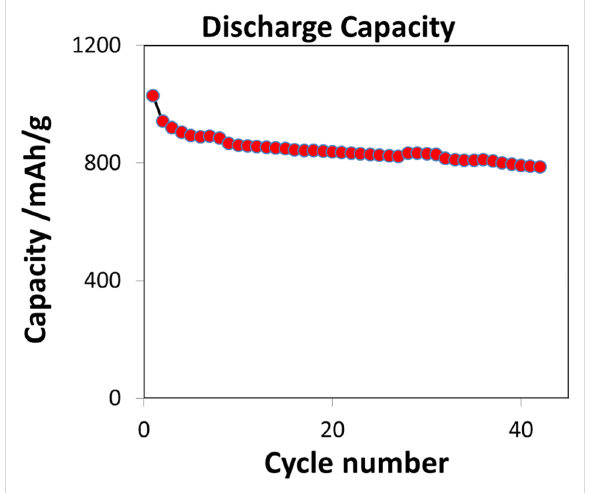
Figure 10: Discharge capacity of the optimized Li–S battery in the range of 2.8–1.5 V vs Li/Li + at a current density of 533 mA·g(sulfur) − 1